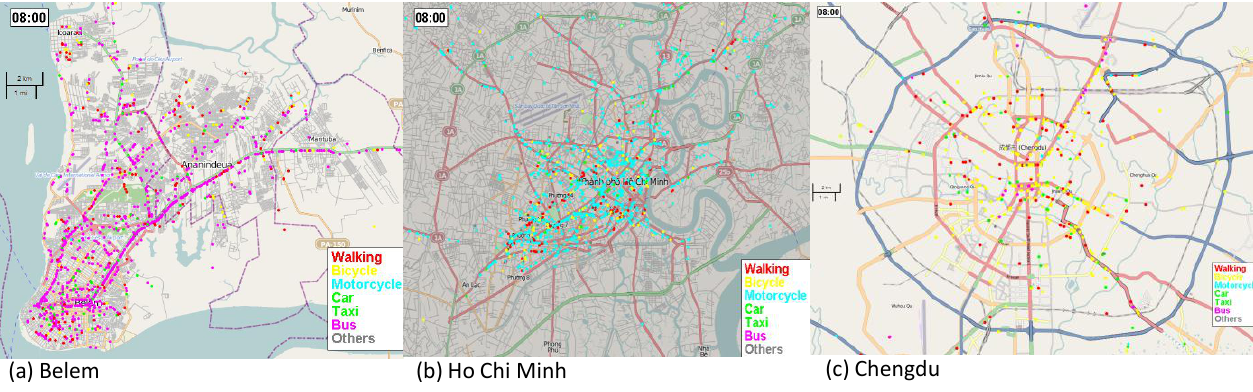
Figure 10. Spatial distribution of people at 8 a.m. in three cities: (a) Belem, (b) Ho Chi Minh, (c)